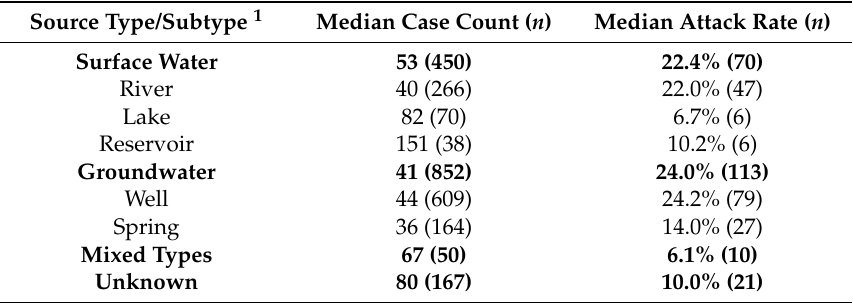
Table 7. Outbreak health data by source type (in bold) and subtype.